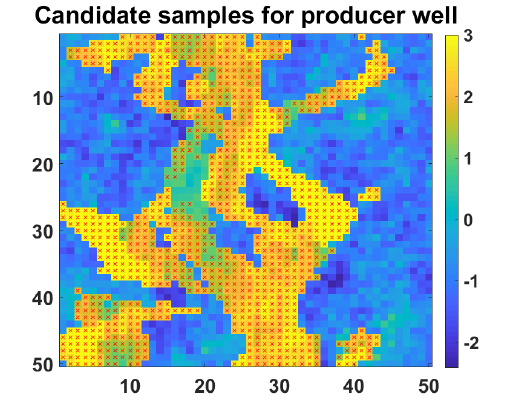
Figure 31. Samples considered as potential well locations shown by red crosses. Injector location is fixed at location (10,1) (not shown here) and hence not sampled.